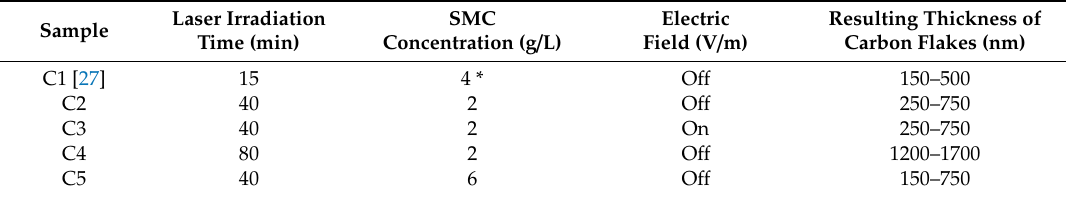
Table 1. Samples with di ff erent fabrication parameters.